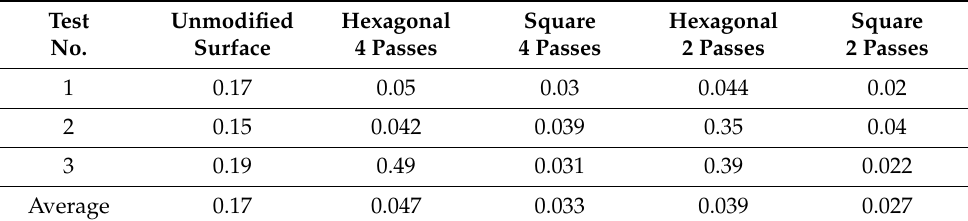
Table 6. Coefficient of friction results.